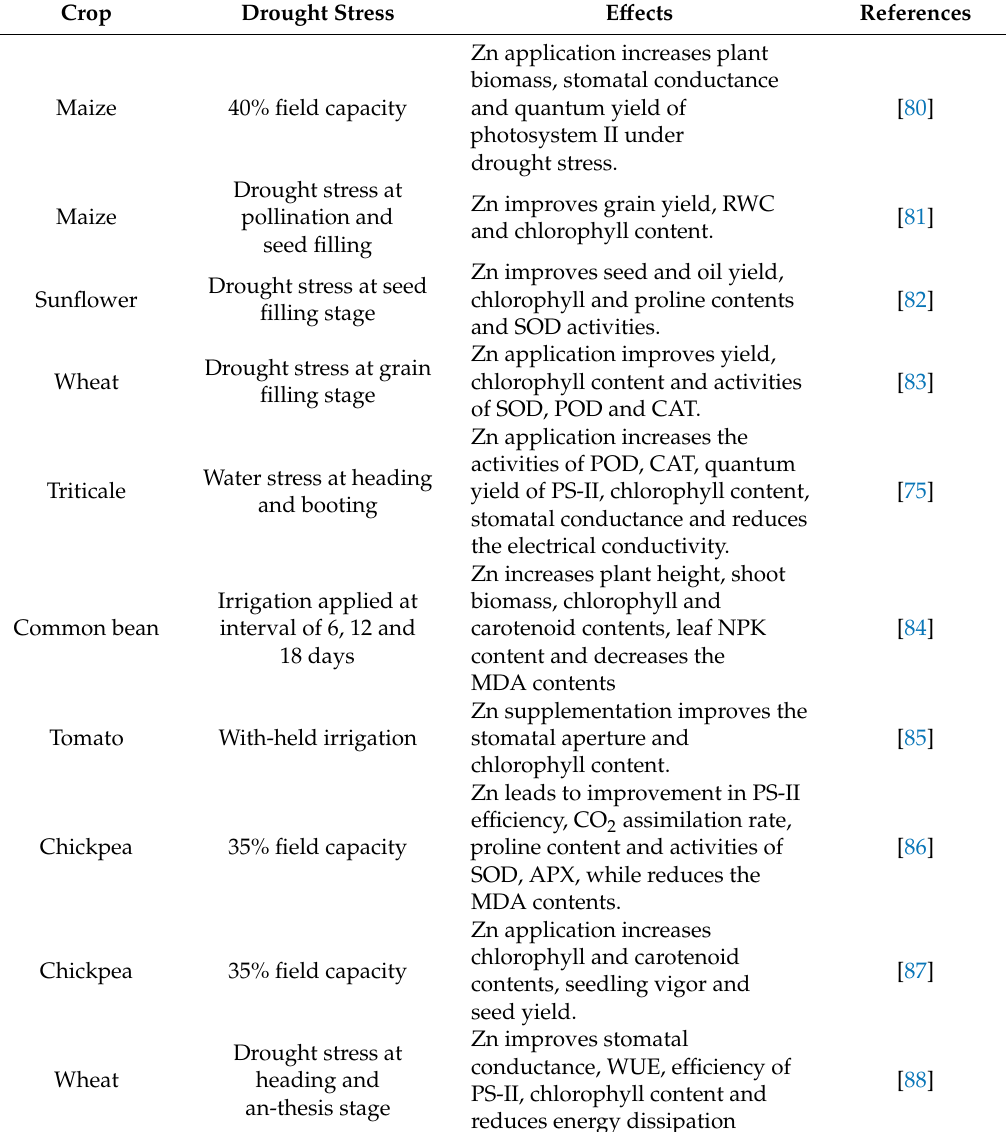
Table 2. E ff ect of Zn application on growth and physiological characteristics in drought